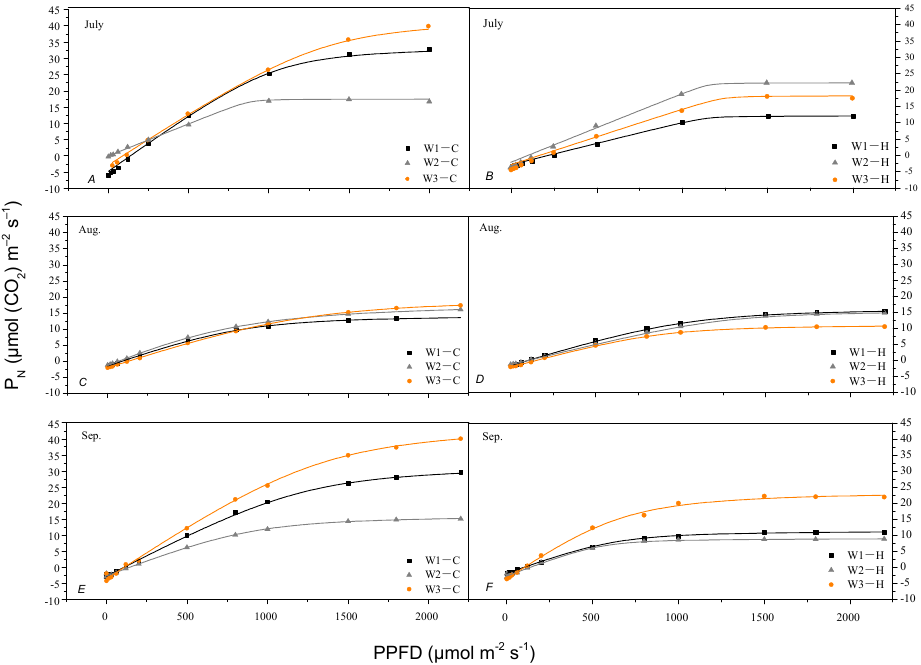
Figure 7. The photosynthetic light response curves (P N ) to photosynthetic photon flux density (PPFD) of C. mongolicum ( C ) and H. ammodendron ( H ) in the low (W1), medium (W2) and high (W3) irrigation amounts in July ( A , B ), August ( C , D ) and September ( E , F